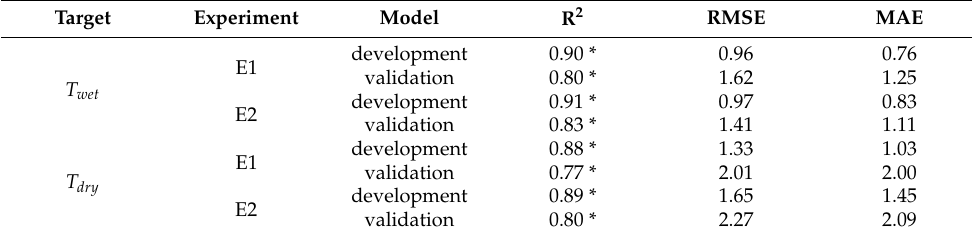
Table 6. Descriptive error statistics of the RF model for predicting T wet and T dry